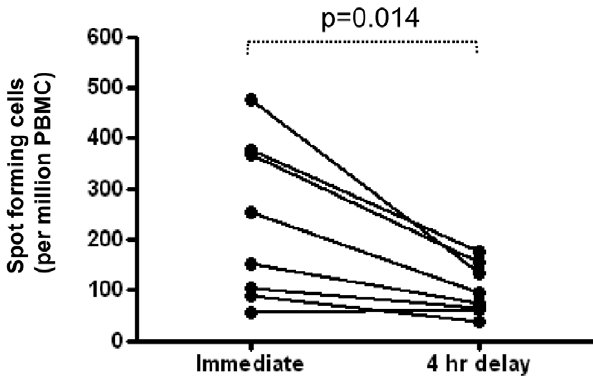
Figure 1. Delays in blood sample processing result in losses of ELISpot assay sensitivity. Aliquots were taken from whole blood samples of BCG-vaccinated adults (n=8) and either processed immediately or delayed for 4 hours at room temperature before PBMC were prepared by centrifugation over Ficoll. PBMC were suspended in AIM-V serum free medium and stimulated with M.tb PPD (10 m g/ml) in ELISpot plates (2.5 6 10 5 PBMC per well) for 18 hours prior to spot development and counting. Plates were developed according to kit manufacturers instructions (Mabtech). Results are SFC per million PBMC in antigen-stimulated samples minus that measured in medium only samples. Statistical analysis is by paired t-test.